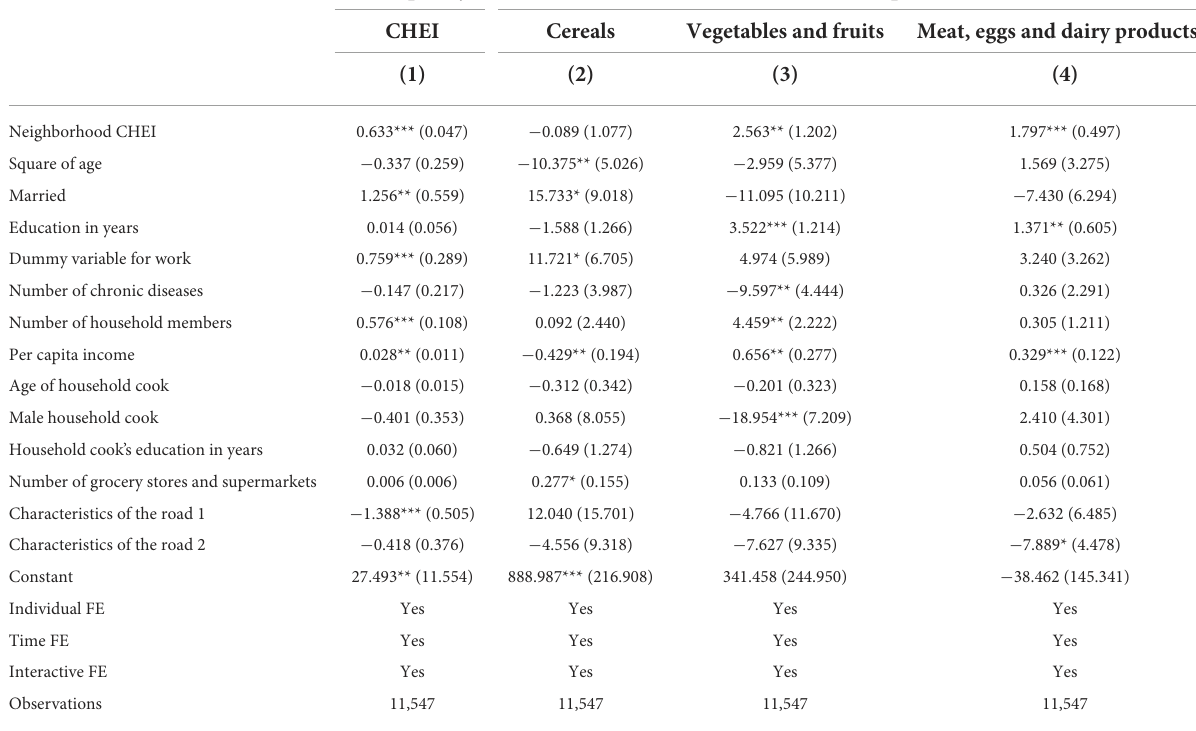
TABLE 3 Estimation of neighborhood effects on dietary behaviors of older adults (fixed effects estimators).